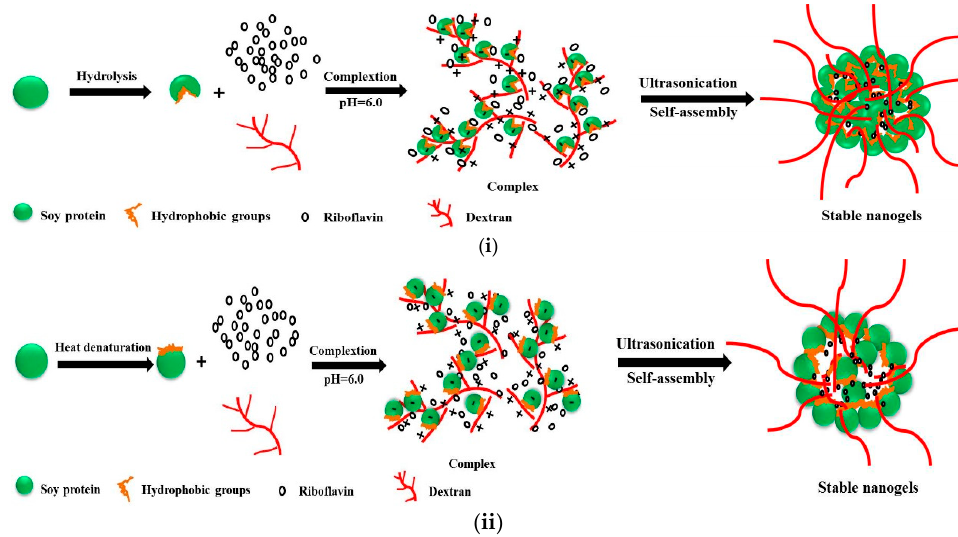
Figure 11. Diagrammatic depiction of modified soy protein/dextran nanogels formation. ( i ) illustration of the fabrication process of NG3; ( ii ) illustration of the fabrication process of NG3.